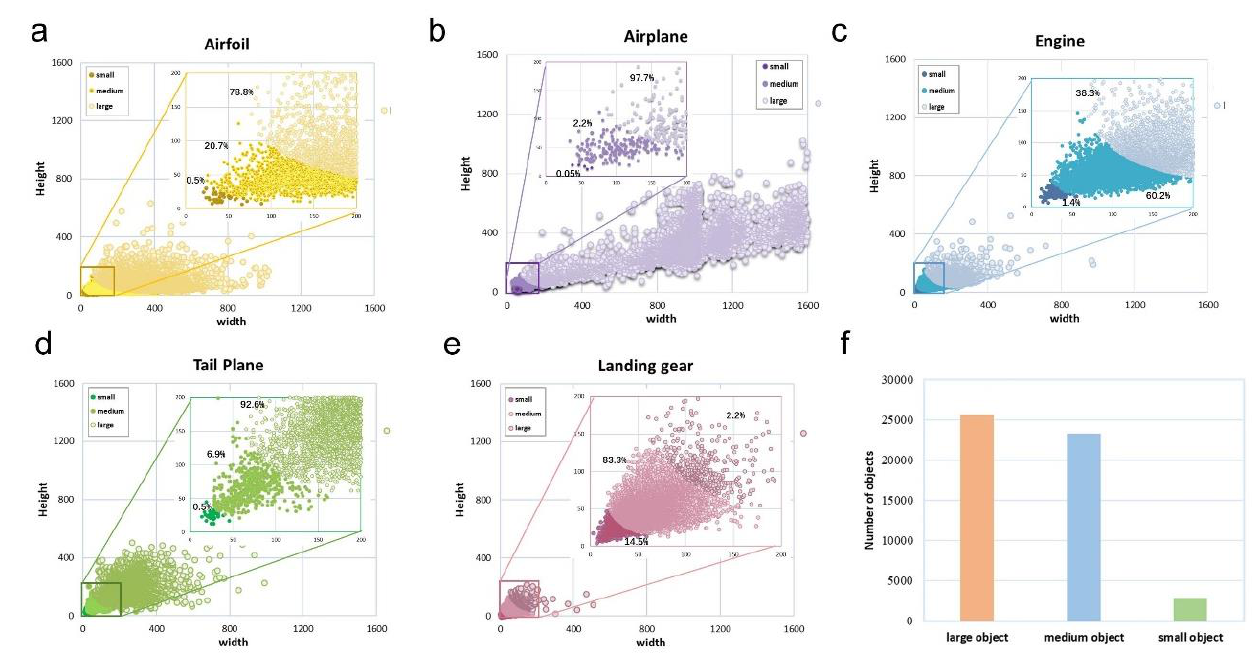
Figure 2. Statistics of multi-scale objects in AP-DATA. ( a ) Statistics of scales of airfoils by length and width. ( b ) Statistics of scales of airplanes by length and width. ( c ) Statistics of scales of engines by length and width. ( d ) Statistics of scales of tail plane by length and width. ( e ) Statistics of scales of landing gear by length and width. ( f ) Statistics of the numbers of objects of different scales.